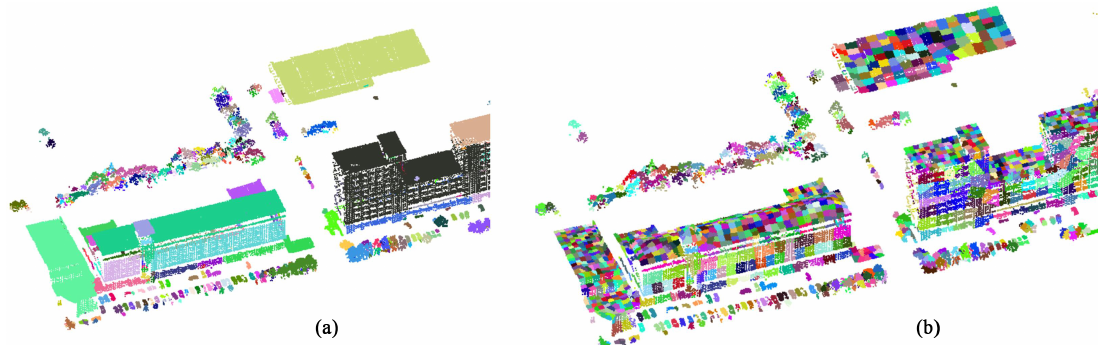
Figure 4. Fine-grained cluster generation using the K-means algorithm. ( a ) The coarse-grained clusters generated by DBSCAN. ( b ) The fine-grained clusters obtained by the K-means algorithm. Please note that different colors represent different clusters. A few colors have been reused, as a result, different disjoint clusters may share the same